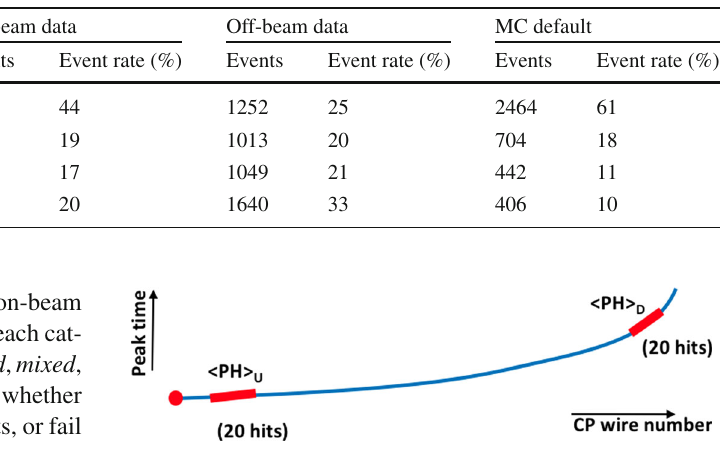
Fig. 4 Diagram showing the PH test for a candidate muon